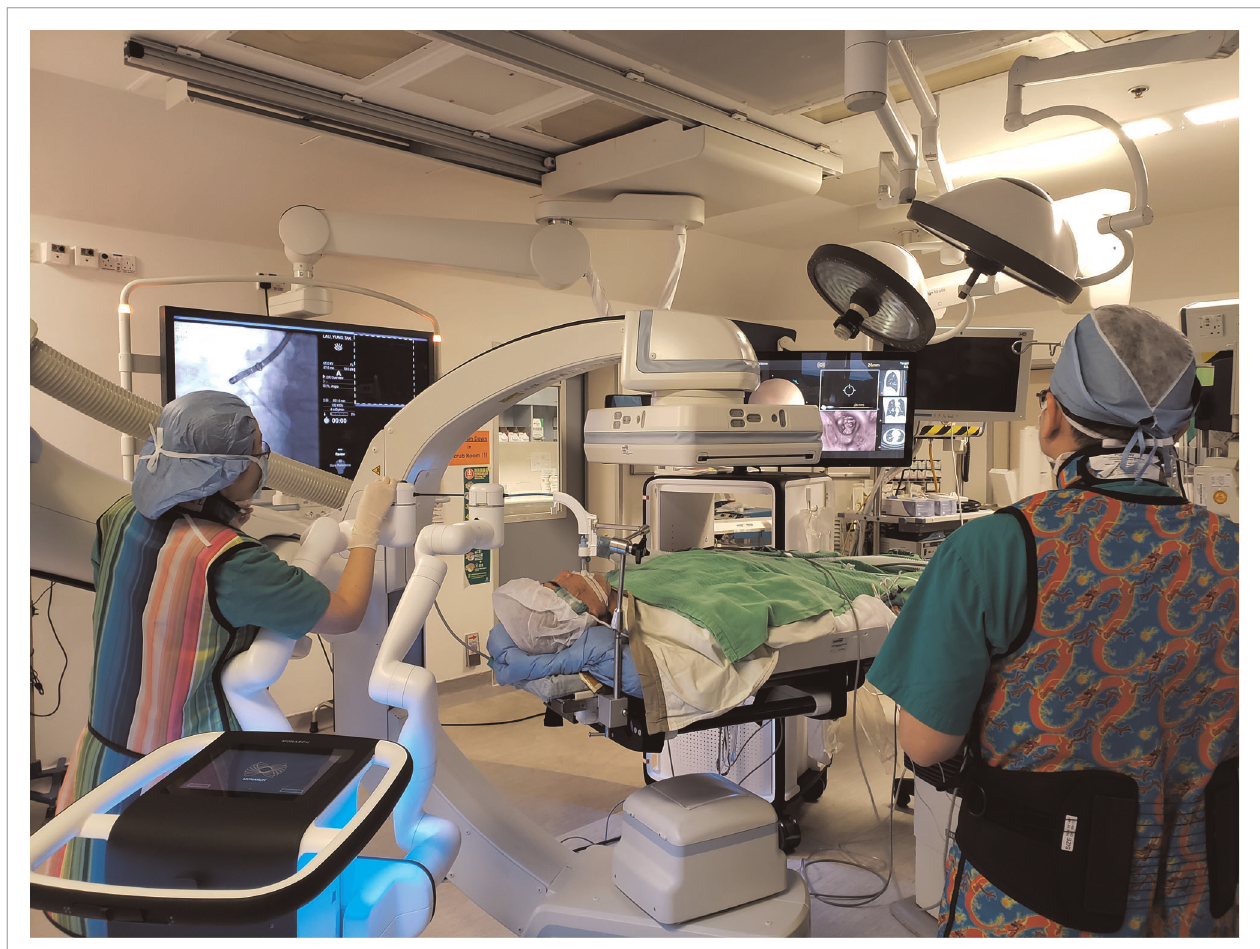
FIGURE 2 | Patient lies supine, intubated by single-lumen endotracheal tube under general anaesthesia. The robotic bronchoscope enters the endotracheal tube via the head-side. Robotic bronchoscopy guided by CBCT in our hybrid operating room is usually performed by two operators. One operator (right) performs fi ne-tuning of the direction of bronchoscope using the controller console, another operator (left) controls the advancement of instruments and commands fl uoroscopic screening using different angles of C-arm. The lesion is usually marked on the fl uoroscopy screen using i-guide® CBCT platform so that the relationship between instruments and lesion can be seen on live fl uoroscopy. In this fi gure, the robotic arm can be seen in very close proximity with the C-arm. Both the robotic platform monitor and the fl uoroscopy screen should be visible to both operators, and communication is important for